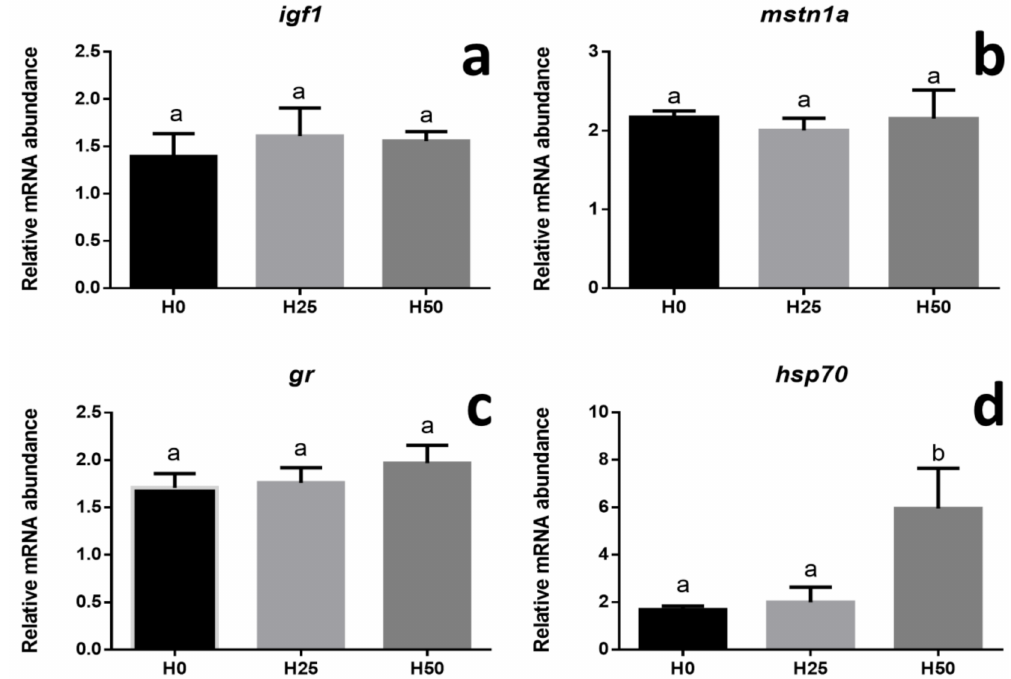
Figure 1. Relative mRNA abundance of genes involved in fish growth ( igf1 and mstn1a ) and stress ( gr and hsp70 ) analysed in liver from trout fed diets including di ff erent H meal levels (H0, H25, H50). ( a ) igf1 . ( b ) mastn1a. ( c ) gr . ( d ) hsp70 . Di ff erent letters indicate significant di ff erences among the experimental groups ( p < 0.05). Values are presented as mean ±